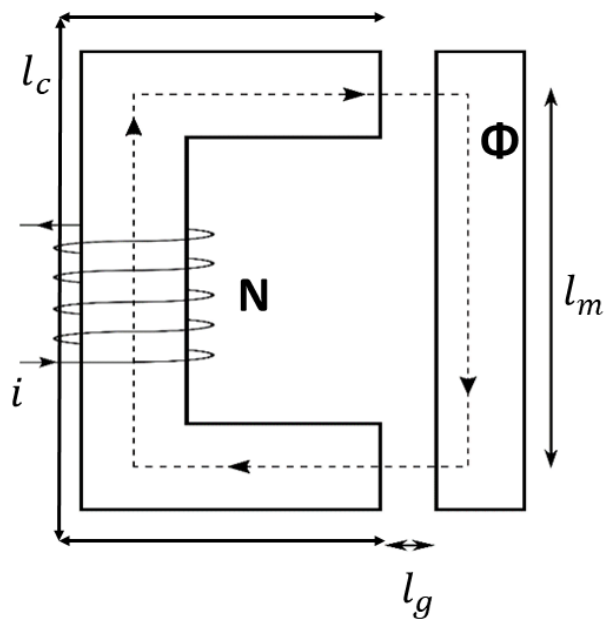
Figure 2. Electromagnet featuring an air gap and a moving mass.